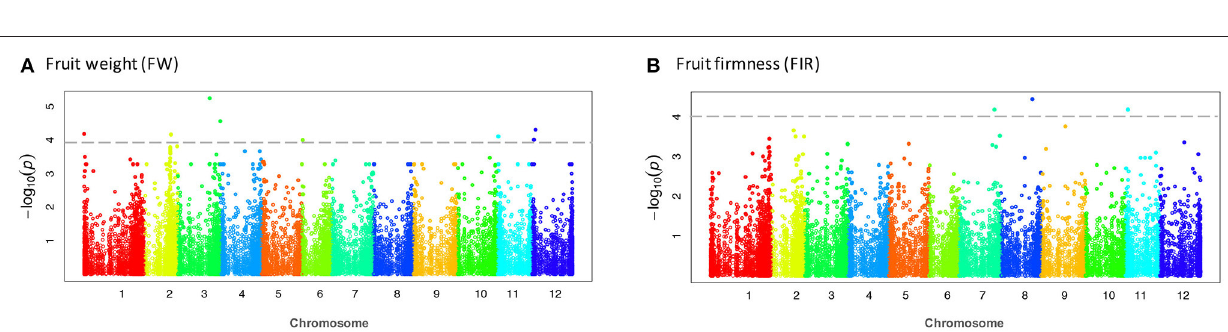
FIGURE 4 | Manhattan plots showing significant associations for fruit weight and fruit firmness. Chromosome number are displayed along the X-axis and the negative log 10 of the association p -value for each SNP on the Y-axis. Higher negative log 10 indicates stronger association with the trait. (A) fruit weight and (B) fruit